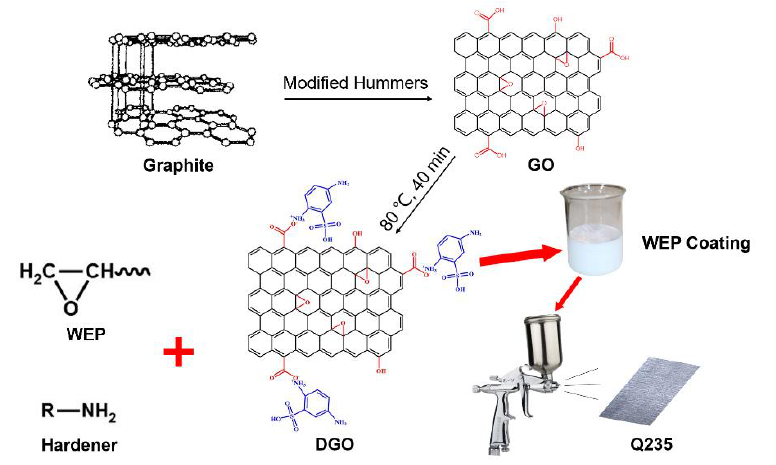
Figure 1. The synthesis scheme of DGO and waterborne epoxy resin coatings.